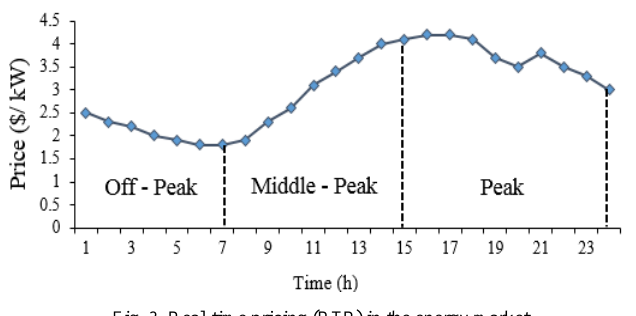
Fig. 3. Real-time pricing (RTP) in the energy market.